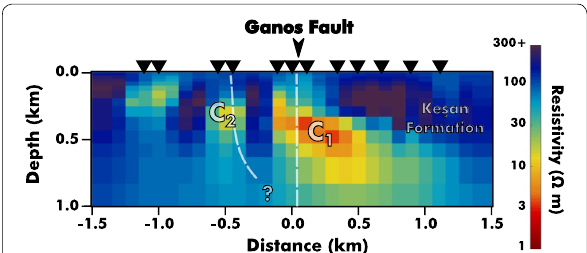
Fig. 4 Resistivity model obtained from the inversion of audio-fre- quency magnetotellurics (AMT) data. Black triangles show the station locations. Thick dashed lines indicate the fault locations. The C 1 and C 2 anomalies are the fault zone conductors of the main Ganos Fault and subsidiary oblique strike-slip structure in the south, respectively. The resistivity color scale is